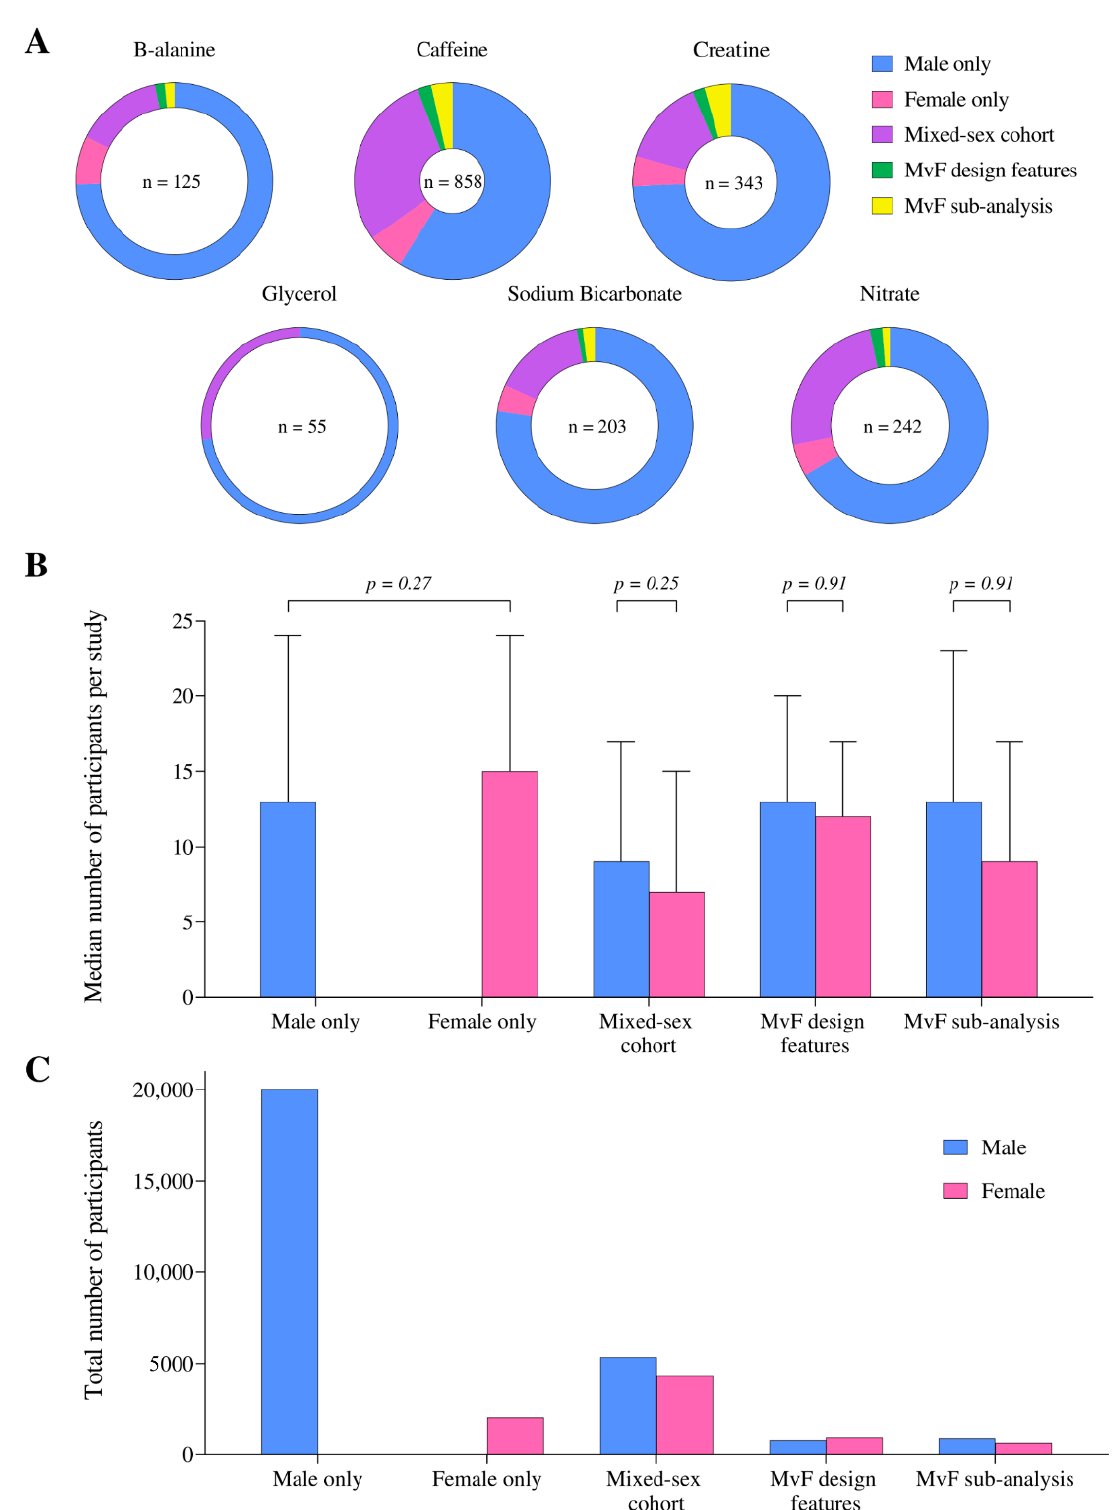
Figure 3. ( A ) The proportion of studies published in each population, separated by performance supplement, ( B ) the median number of male and female participants per study, and ( C ) total number of male and female participants, according to the population studied. Male versus female (MvF).